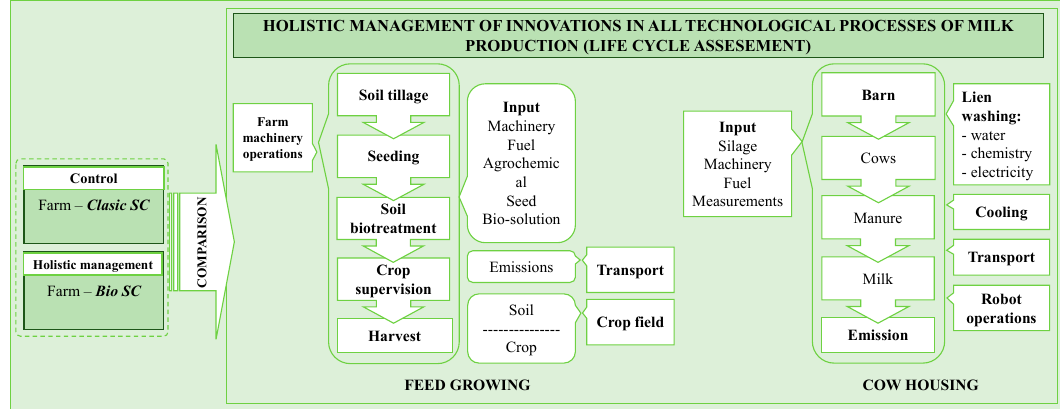
Figure 1. Holistic model of technological process management.